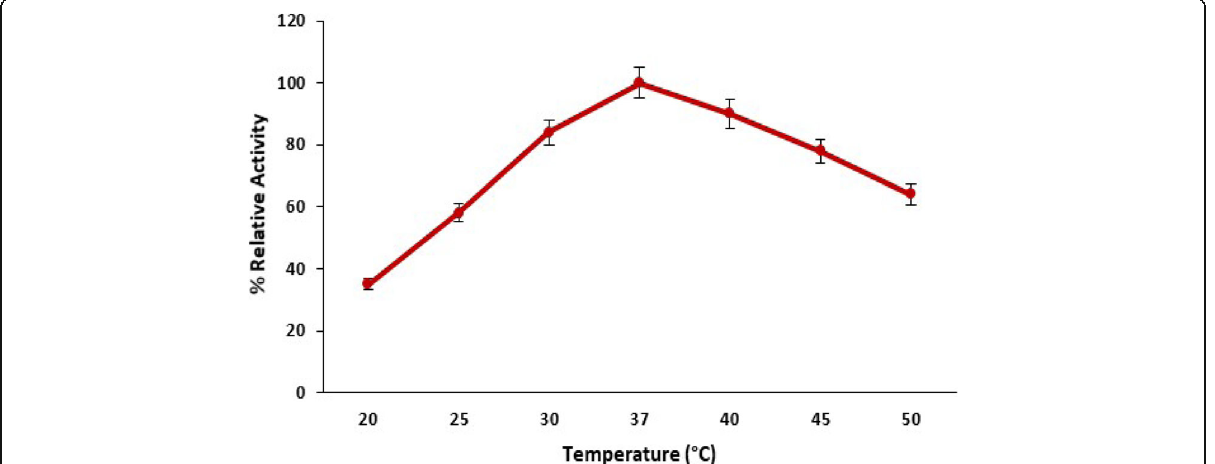
Fig. 4 The influence of temperature on pectinase production by B. licheniformis KIBGE-IB3 using date fruit wastes as substrate (means ± S.E., n = 6)